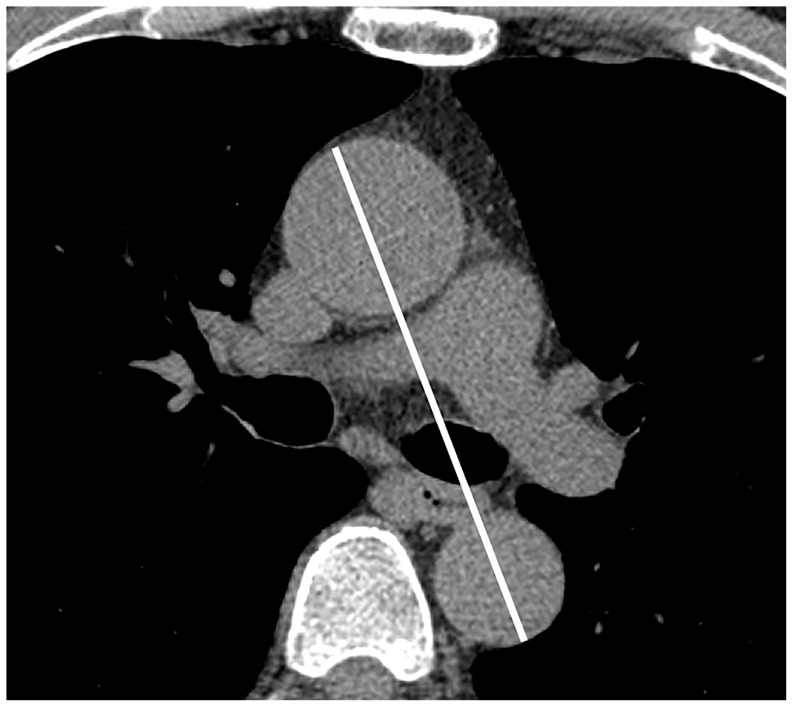
Measuring aortic unfolding.Aortic unfolding (white line) was defined as the longest distance between the ascending and descending aorta on a transaxial slice at the level of the pulmonary artery bifurcation on a selected coronary artery CT image.